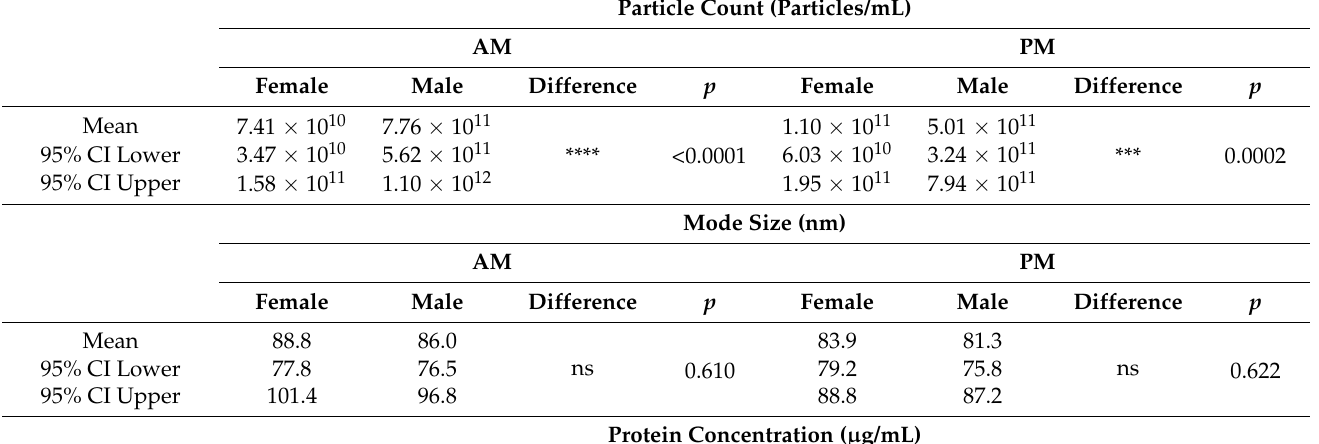
Table 5. Pooled analysis of EVs collected from serum of healthy female ( n = 10) and male ( n = 10) volunteers on study days 1 and 3 in the morning and afternoon. Data presented as geometric mean and 95% confidence interval (CI) of particle count, mode size, total protein concentration, and EV-associated protein marker abundance. Statistical analysis performed